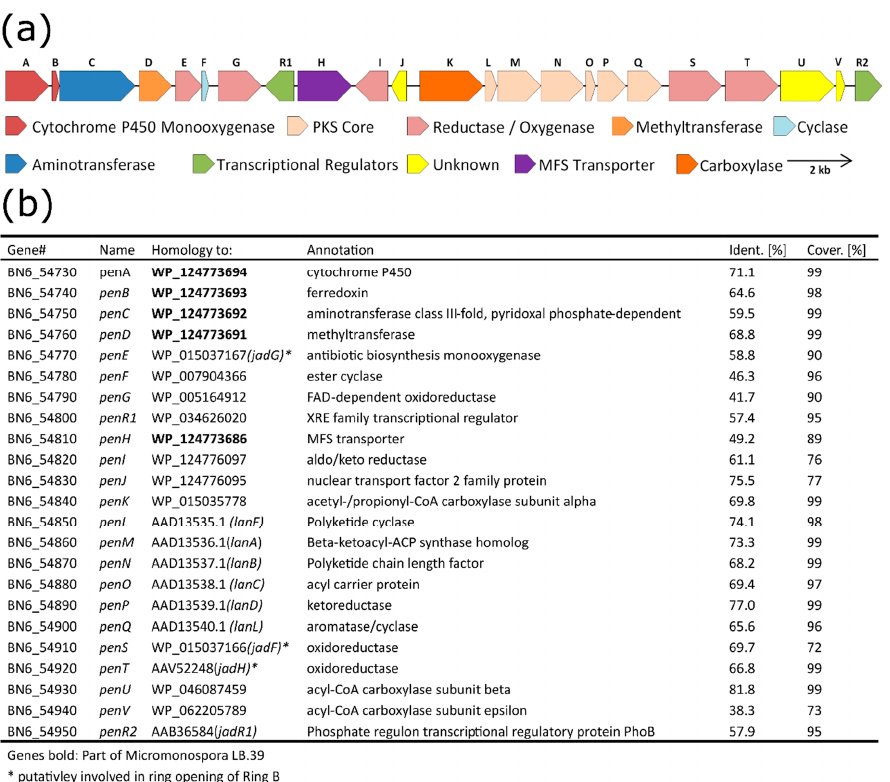
Figure 3. Schematic representation of the biosynthetic gene cluster of pentangumycin ( a ) and a BLAST analysis of the pen genes ( b ).